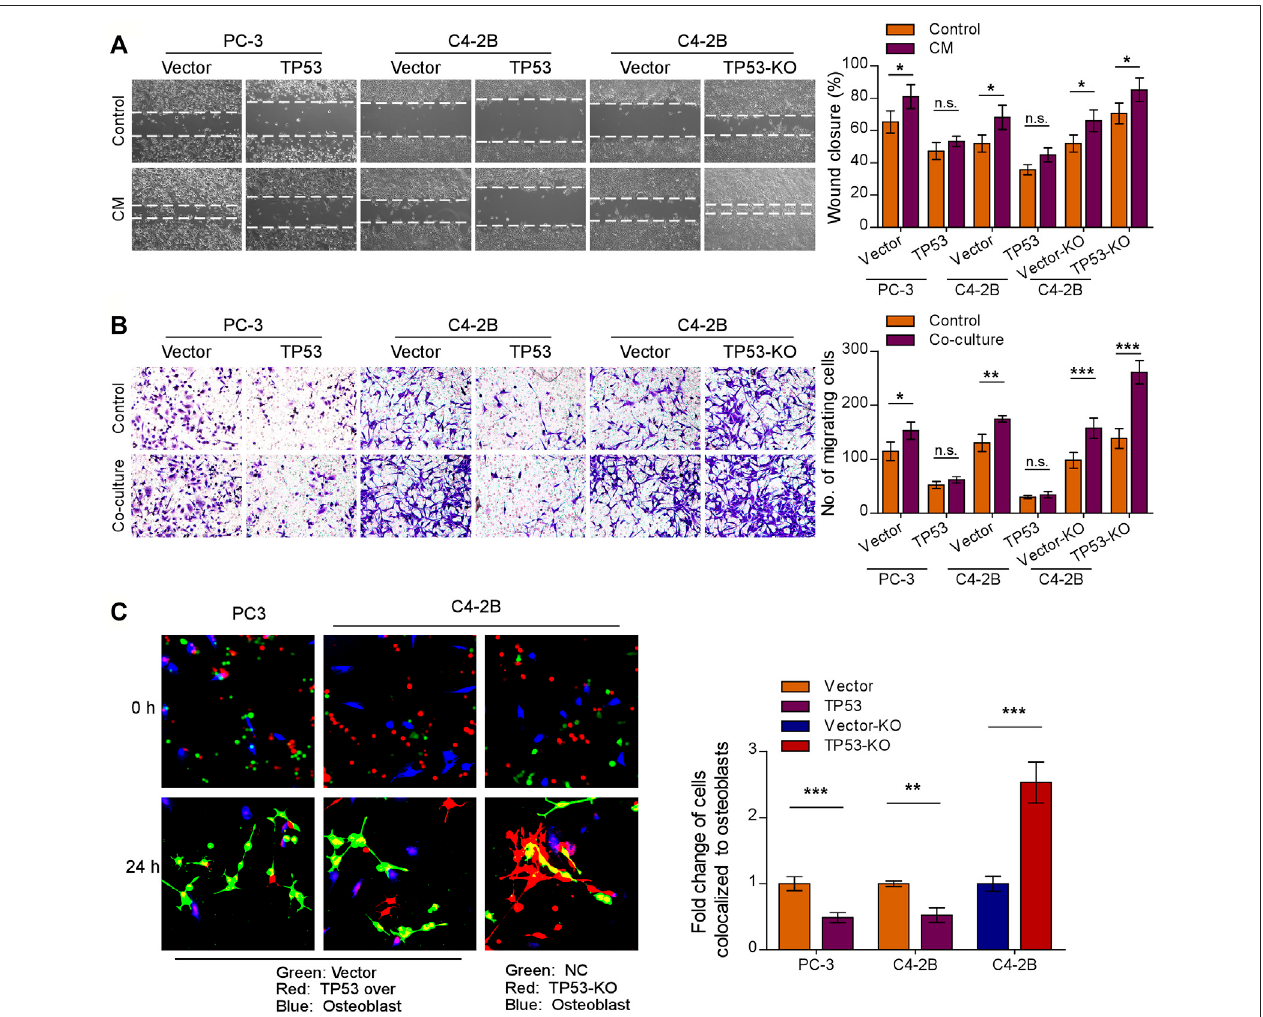
FIGURE2| Depletionofwt-p53increasesprostatecancercellschemotaxistoosteoblasts. (A) Representativeimages(leftpanel) andquanti fi cation(rightpanel)of wound-healing assaysfortheindicatedcelllines.Woundclosurewasphotographed at24 hafterwounding.Prostate cancercellswerecultured inMC3T3-E1condition medium (CM). (B) Representative micrographs (left panel) and quanti fi cation (right panel) of the migration of indicated cells in transwell assays. Co-culture, tumor cells (top chamber) were co-cultured with primary osteoblasts (bottom chamber) in the transwell plate. (C) Representative images (left panel) and quanti fi cation (right panel) of in vitro competitive colocalization assays for the indicated cells by confocal microscopy. Error bars represent the means ± SD of 3 independent experiments. * p < 0.05, ** p < 0.01, *** p < 0.001, n. s., no signi fi cance. Original magni fi cation, A, × 100; B, × 200; C, × 400.